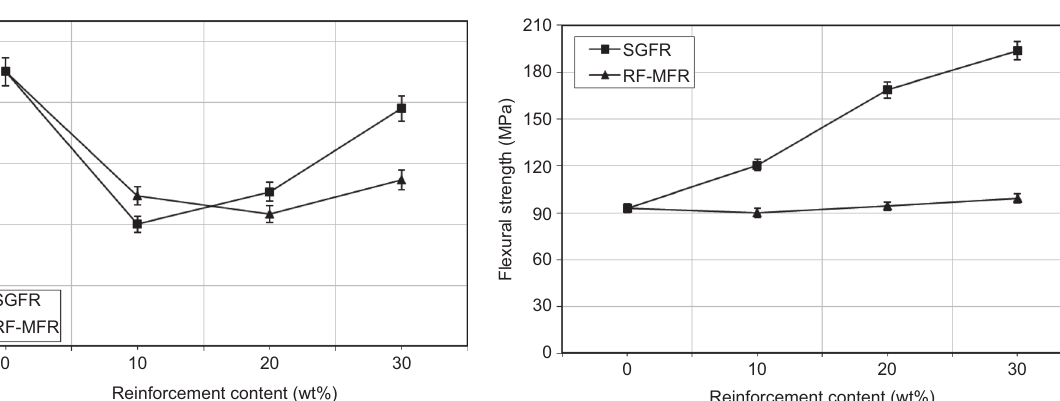
Figure 6 Variation of the flexural tensile strength of PA6 with weight percent of reinforcement content.